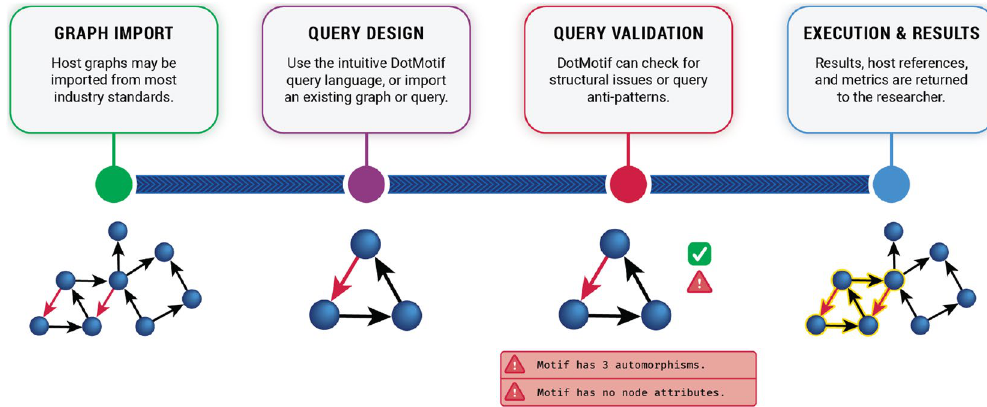
Figure 6. The DotMotif query execution process. Graph import . A user may import a search graph (also commonly referred to as a host graph) from a variety of industry standard formats, including an edgelist CSV, GraphML, numpy adjacency matrix, and any format supported by the NetworkX library. Furthermore, DotMotif is compatible with graphs stored in neuPrint schemas in a Neo4j database 6 . Query design. The